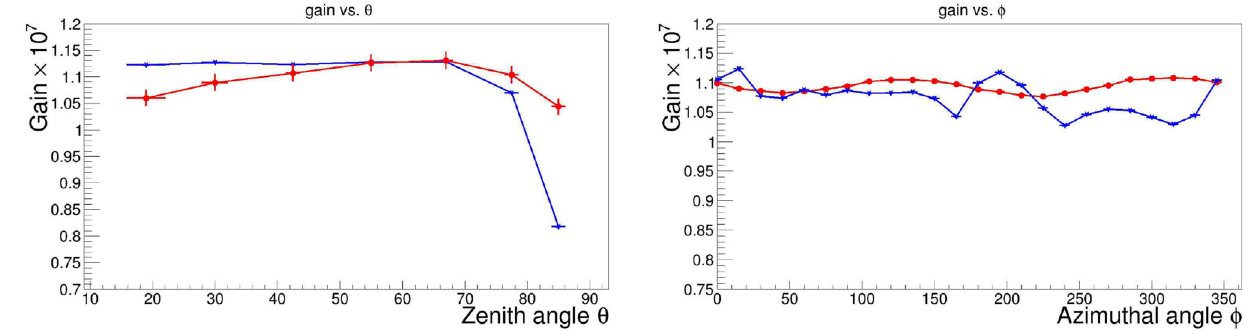
Fig. 34 Uniformity of gain along the zenith angle ( θ , left) and azimuthal angle ( φ , right). HPK: blue; NNVT: